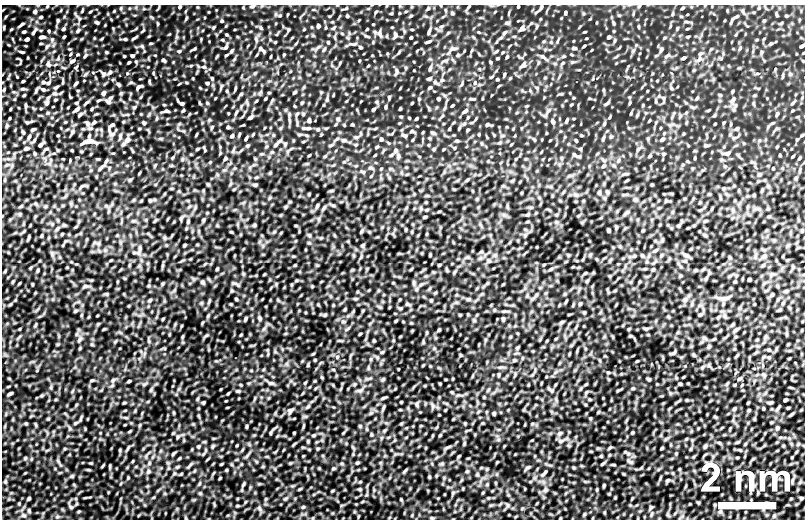
Figure 11. HREM image of an as-prepared amorphous sample.